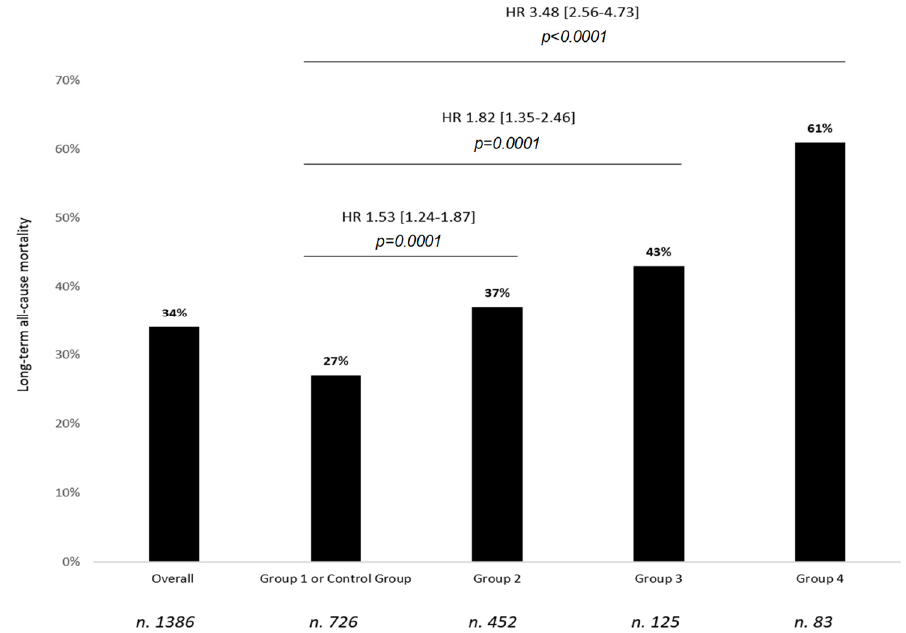
Figure 1. Overall long-term survival and prognostic differences between the investigated study subgroups. Group 1: patients who never developed AF (control), Group 2: patients with no history of AF before surgery in whom POP AF was clinically detected (new-onset POP AF), Group 3: patients with pre-surgical history of paroxysmal/persistent AF, and Group 4: permanent AF patients. A raw estimate of long-term all-cause mortality is reported for each study subgroup. Comparisons between different study subgroups are reported as hazard ratios (HR) and related 95% confidence intervals [squared brackets], and p -values as assessed in the univariable analysis. Corrections for multiplicity did not significantly change confidence intervals for comparisons. Number of patients for each study group is reported below each bar. POP AF: post-operative atrial fibrillation.